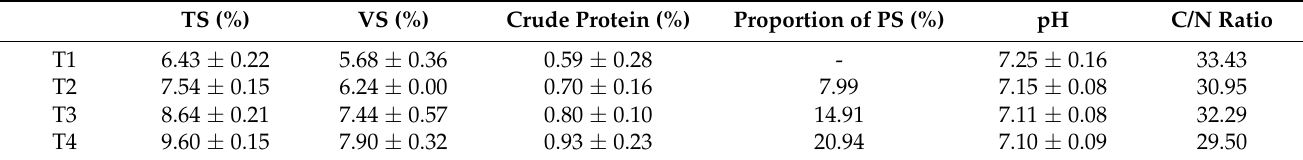
Table 2. Continuous experiment substrate